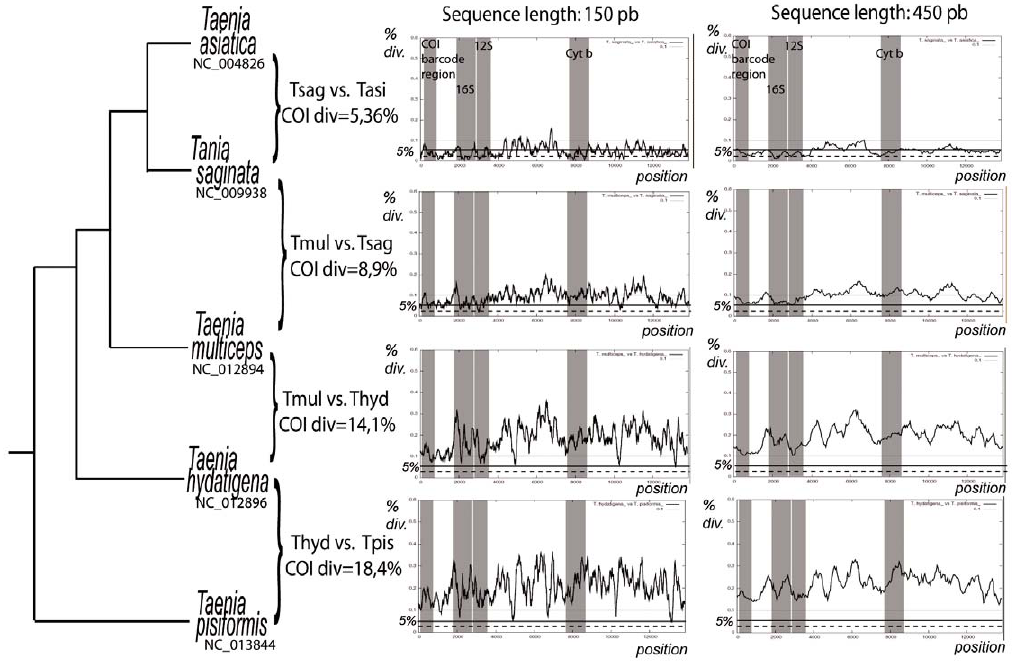
Figure 3. Sliding window analysis for checking mitogenome divergence before multiplexing. COI (or other mitochondrial marker) divergence can serve as a proxy to estimate sequence divergence over the whole mitogenome for fragments of the same length as generated by the NGST used. In the absence of sequence data, taxonomy can serve the same purpose, albeit less efficiently. There is much more variation between small fragment divergences than large fragment divergences, so while only distant species might be multiplexed when using short fragments generating sequencers, less distant species might be multiplexed if the sequences are longer. Some species are too similar to be multiplexed at all, except if additional tagging is used. Phylogeny follows Knapp et al. 2011.